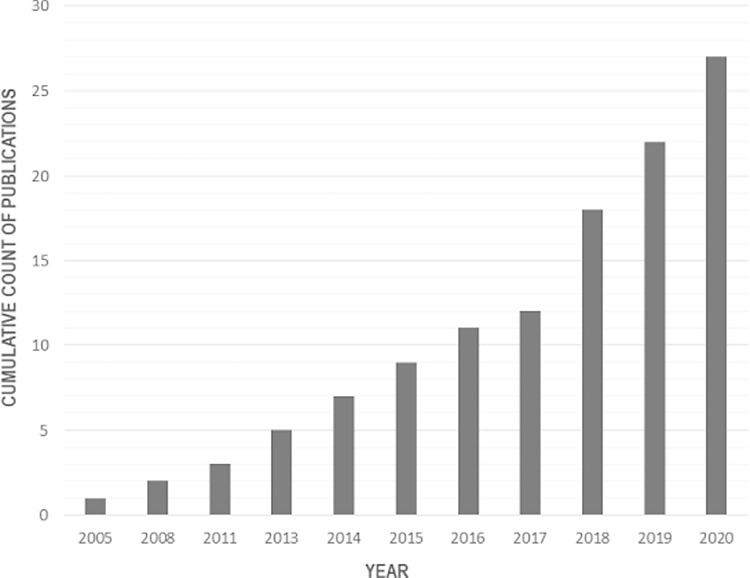
Cumulative count of GA-AI publications. There is an increasing trend of GA-AI publications. AI, artificial intelligence; GA, geographic atrophy.